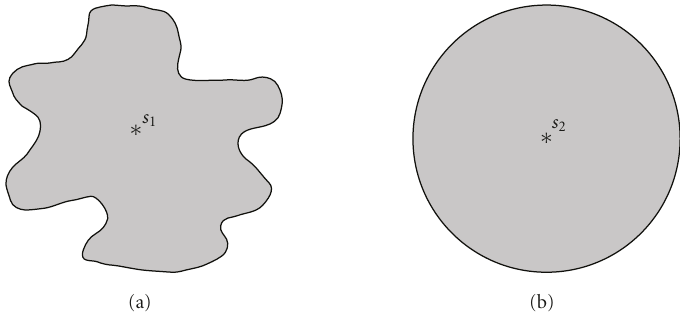
Figure 1: Sensing regions associated with a sensor: (a) a general shape that is closed, connected, and without holes, and (b) a disk.